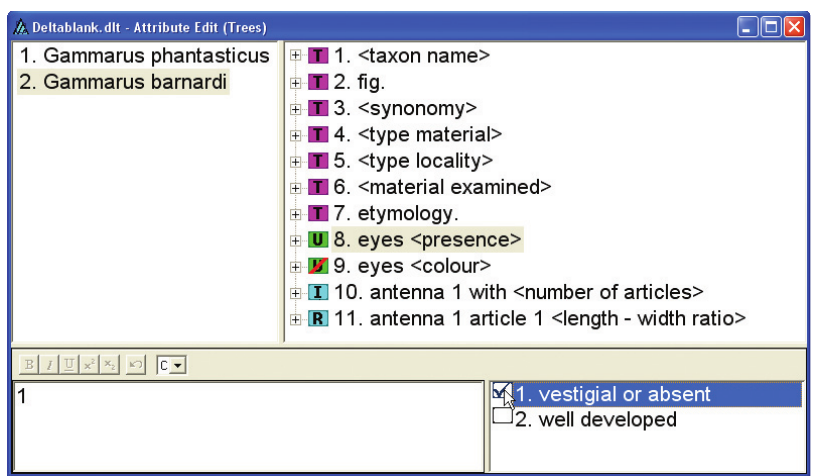
Figure 11. Recording the characters using the check boxes for states in the lower right